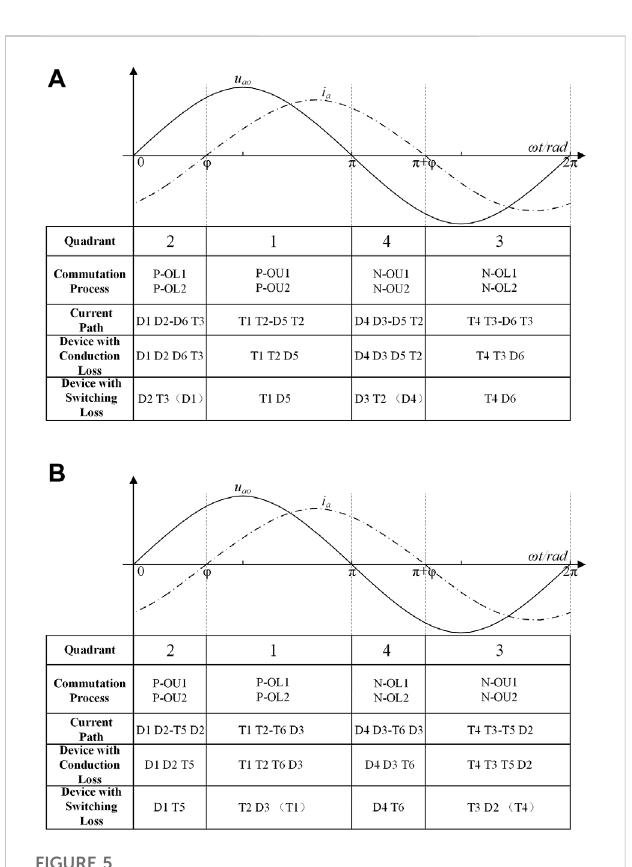
Loss distributions. (A) Passive commutation mode. (B) Active commutation